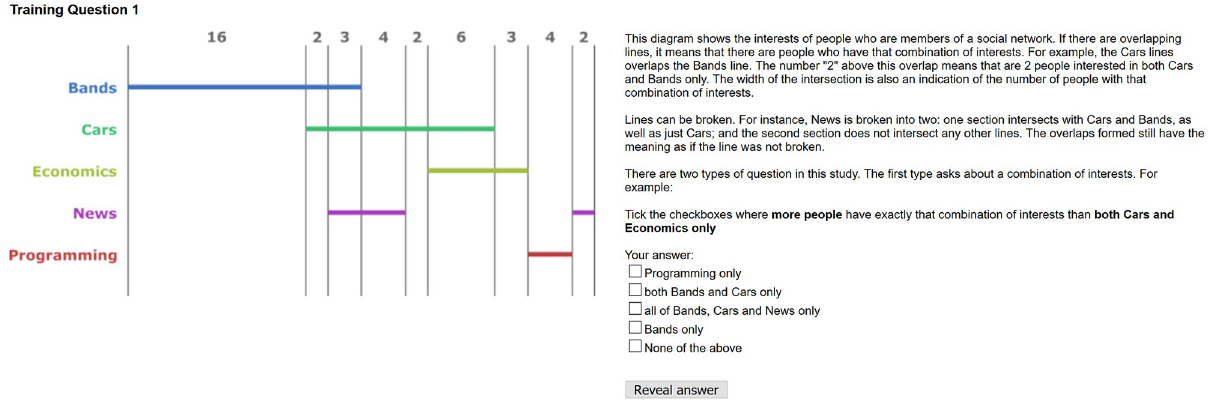
Fig 5. The first training page.